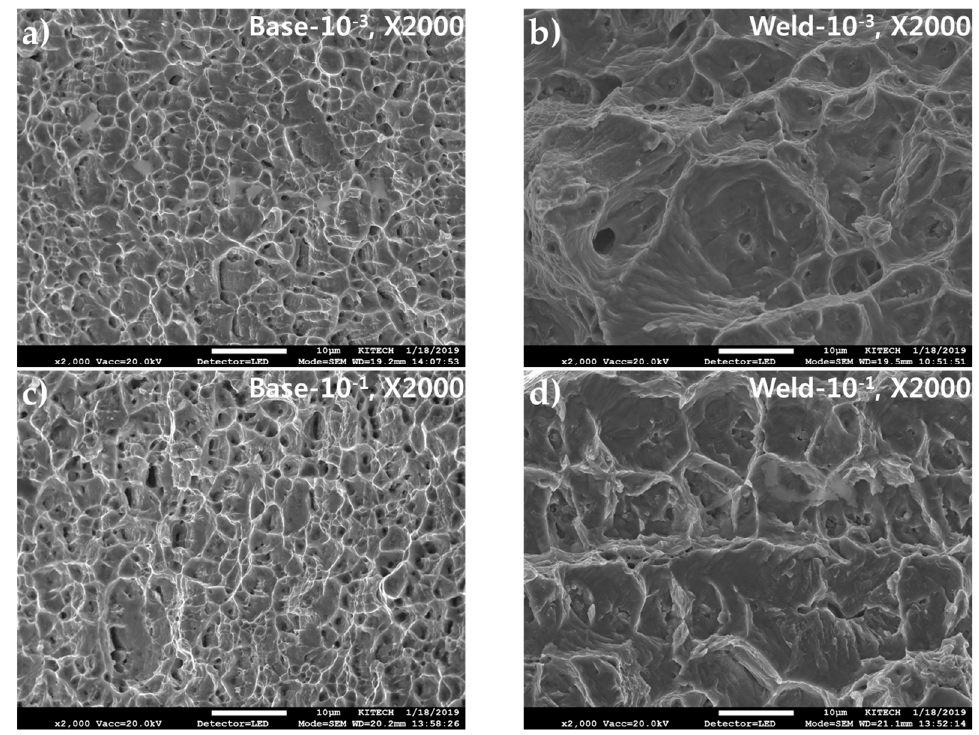
Figure 8. The results of uniaxial tensile test on the base and the weld zone. All specimens were deformed along the welding (rolling) direction: ( a ) engineering stress–strain curves (strain rate of